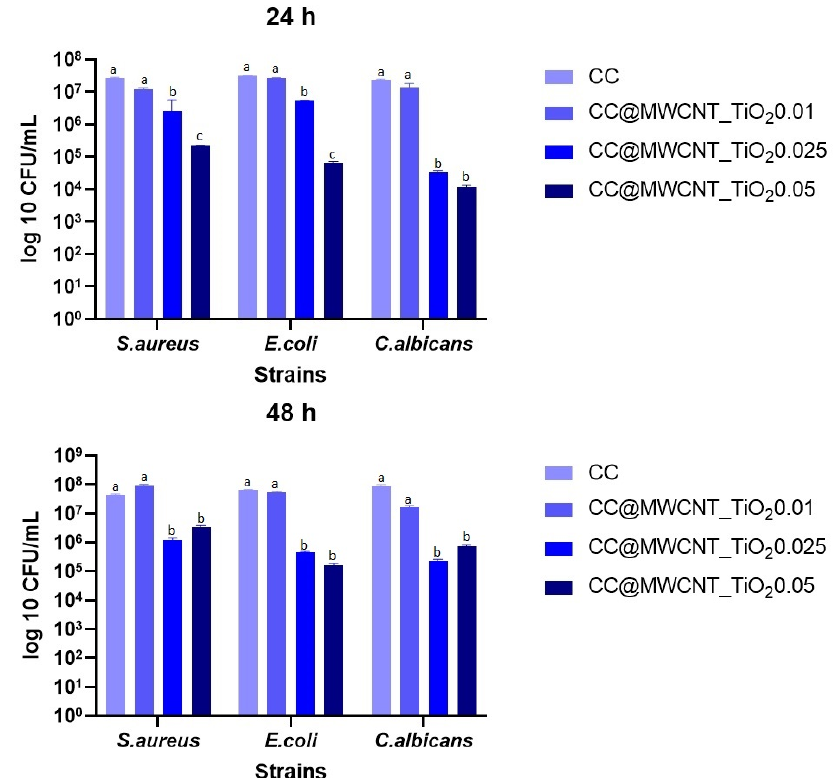
Figure 10. Values of log10 CFU/mL for the tested bacterial strains, expressing biofilm-embedded cells developed on the obtained films after 24 h ( up ) and 48 h ( bottom ) incubation. Different small letters (a, b and c) indicate statistically significant differences between films ( p < 0.05).